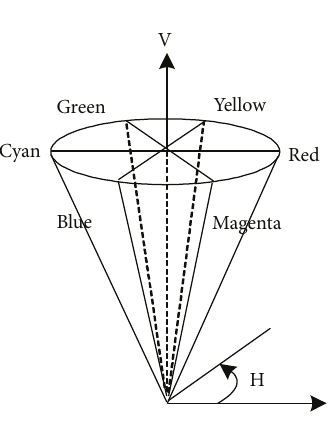
Figure 3: HSV color